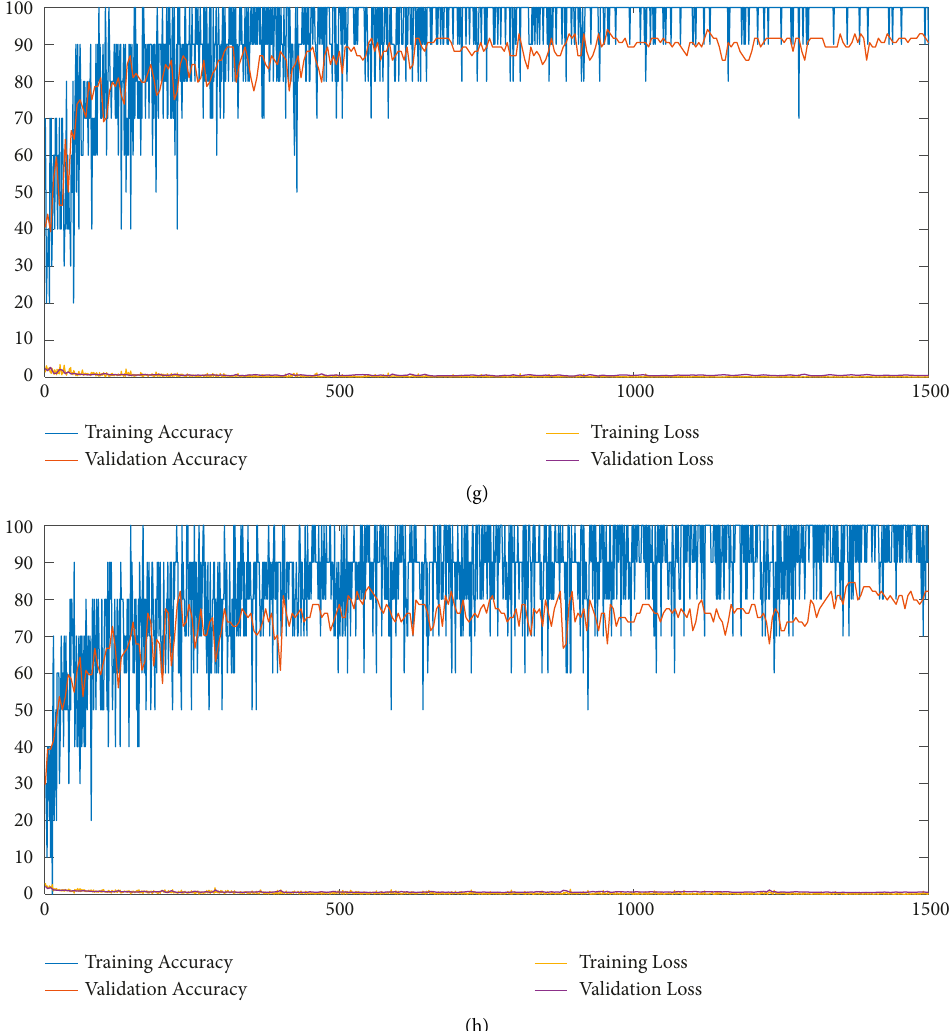
Figure 6: Accuracy and loss of different network models. (a)Accuracy and loss in the AlexNet training process. (b) Accuracy and loss in the ResNet-18 training process. (c) Accuracy and loss in the ResNet-50 training process. (d)Accuracy and loss in the ResNet-101 training process. (e)Accuracy and loss in the GoogLeNet training process. (f) Accuracy and loss in the VGG-16 training process. (g) Accuracy and loss in the VGG-19 training process. (h) Accuracy and loss in SqueezeNet training